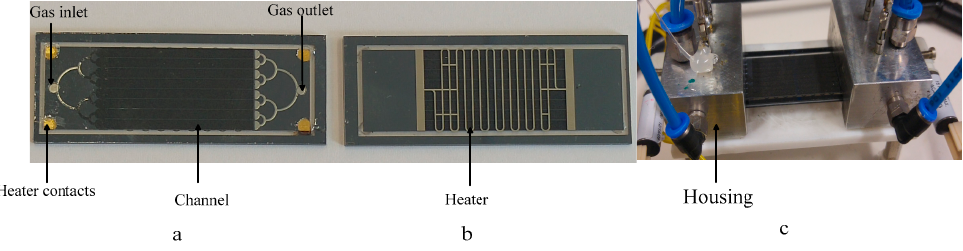
Figure 6. Preconcentrator. ( a ) Front side; ( b ) back side; ( c ) with housing.